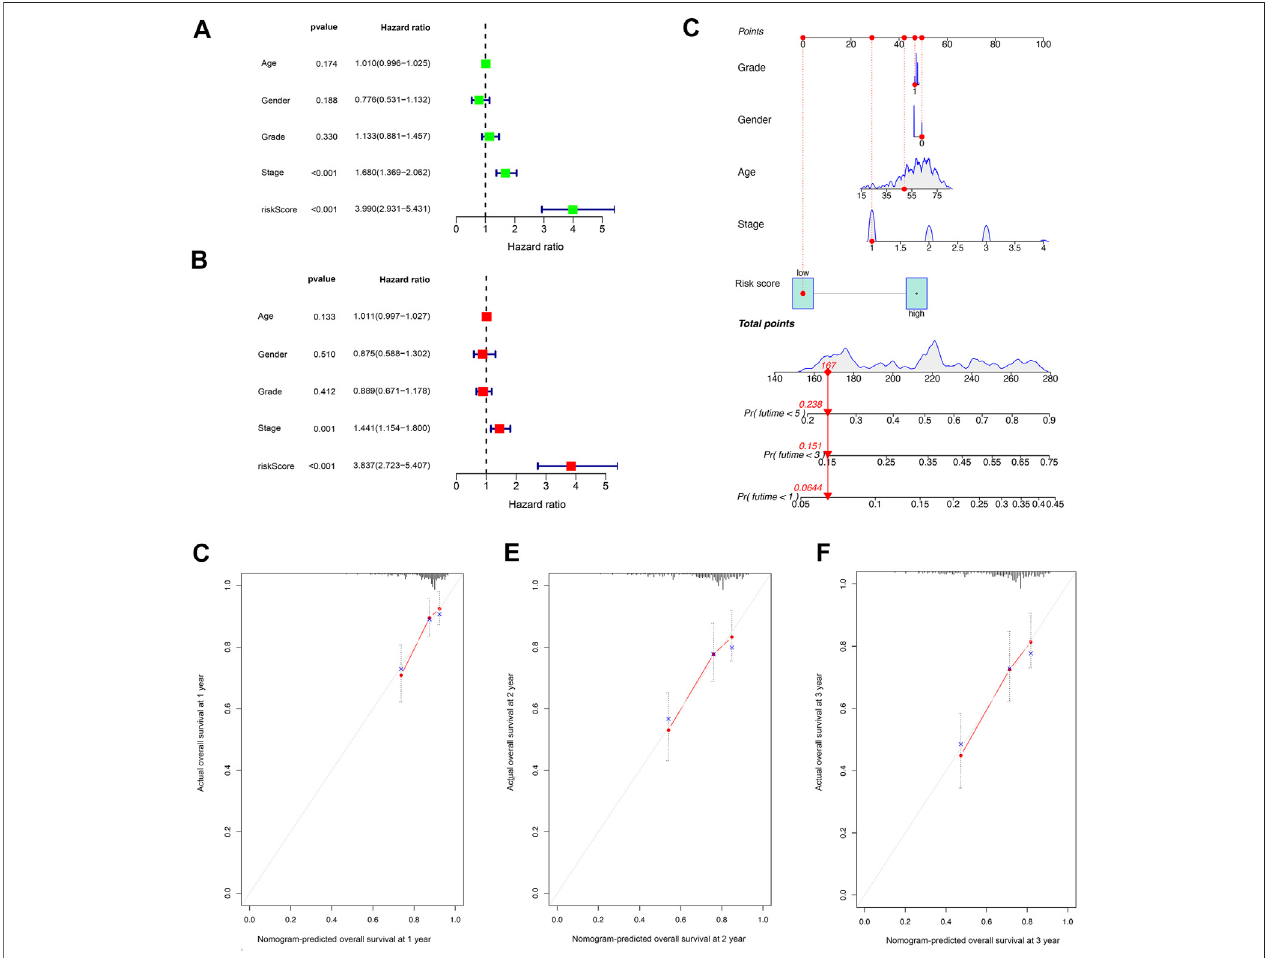
FIGURE 4 | Establishment and assessment of the nomogram for survival prediction. (A,B) Univariate and multivariate Cox regression analyses showed that the lncRNA risk score associated with pyroptosis is an independent prognostic factor affecting the prognosis of HCC patients. (C) The nomogram combined pyroptosis- related lncRNA risk score and other clinicopathological parameters was developed to predict 1-, 3-, and 5-year survival. Calibration curves showing the nomogram that we established predictions for 1-year (D) , 2-year (E) , and 3-year (F) survival.